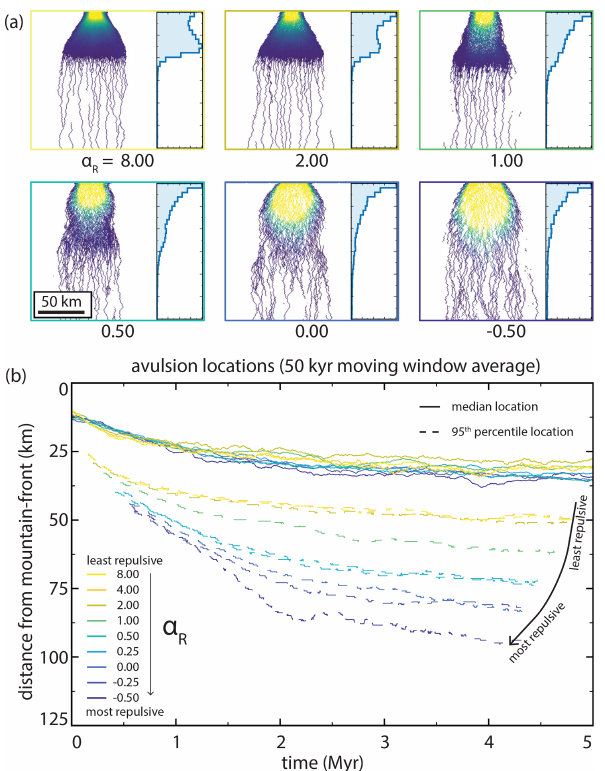
Figure 10. The effect of abandoned channel repulsion on (a) plan- form appearances and normalized avulsion location histograms and (b) median avulsion locations through time. Decreasing α R causes avulsion location to move downstream. These changes are more pronounced for 95th percentile locations. Color scale for inset plan- form appearances is the same as in Fig. 6.